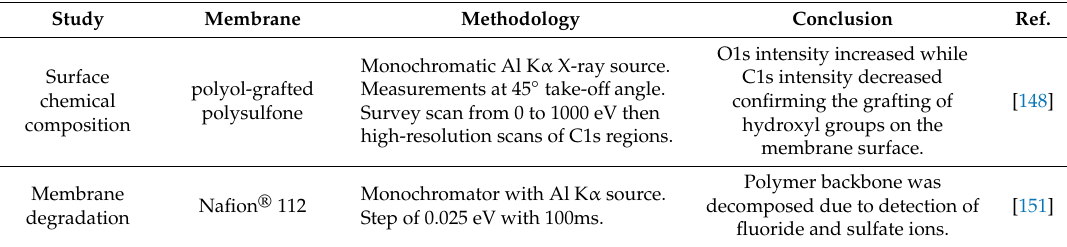
Table 12. Studies for membrane characterization by